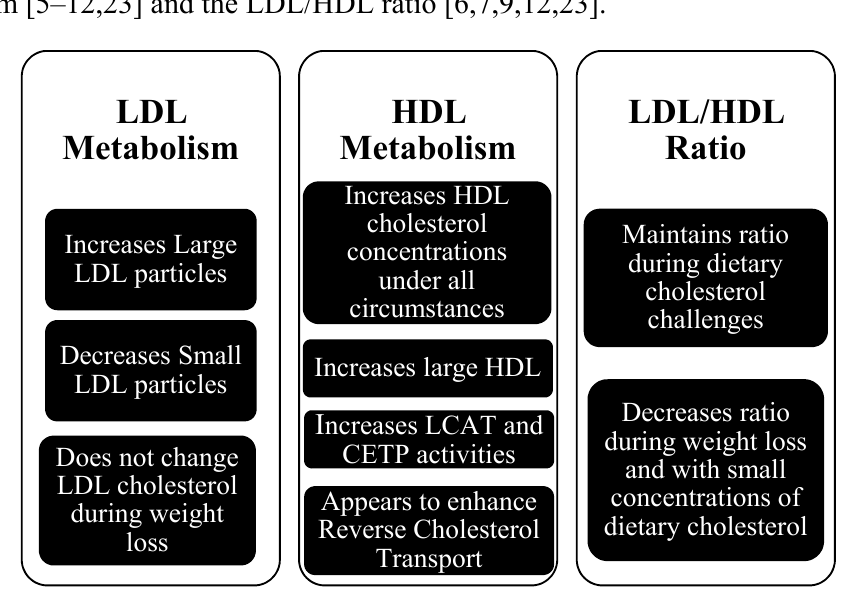
Figure 1. Effects of Dietary Cholesterol on LDL metabolism [5–12,23] HDL metabolism [5–12,23] and the LDL/HDL ratio [6,7,9,12,23].